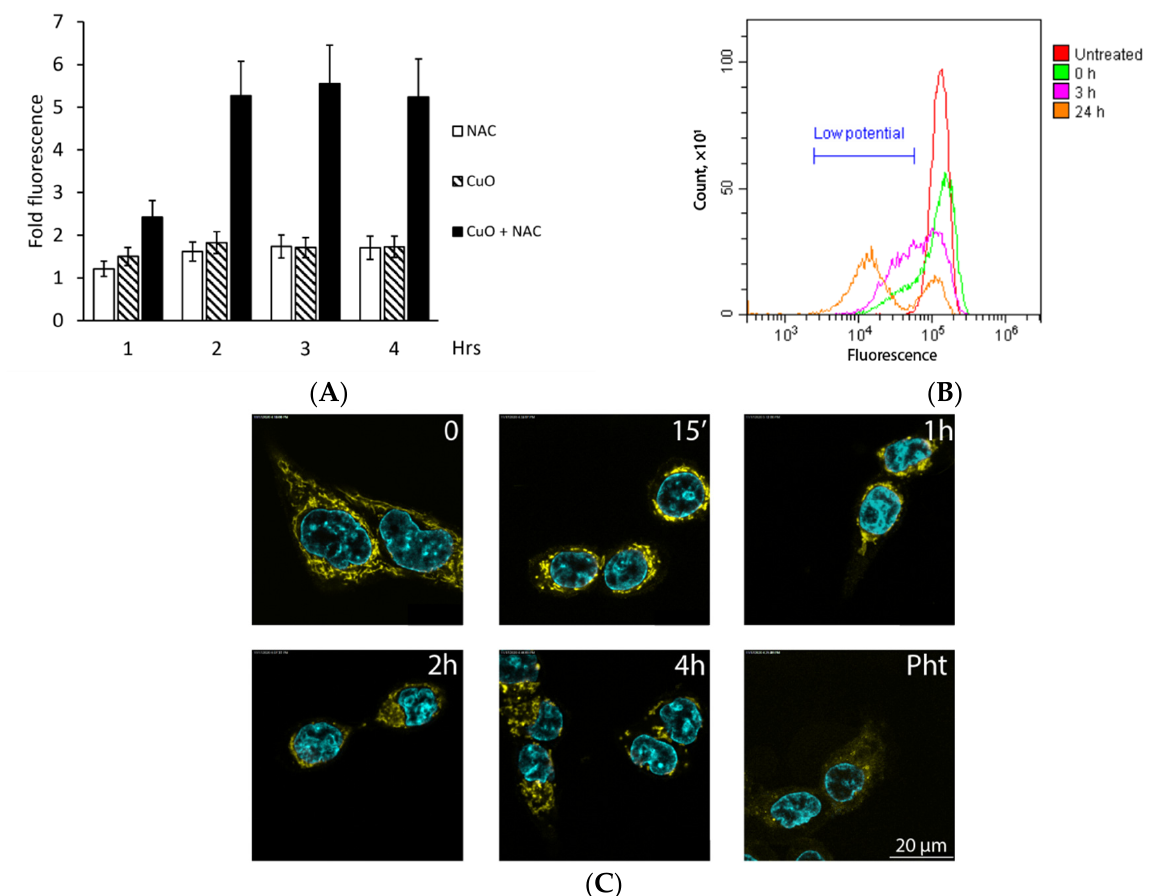
Figure 2. ROS burst and mitochondrial responses upon treatment with the combination of 1 µ g/mL CuO and 1 mM NAC. ( A , B ): K562 cells; C : HCT116 cells. ( A ) Carboxy-H 2 DCFDA (5 µ M) was added 30 min before the addition of the combination. Cell-associated fluorescence was measured in the FITC channel. Mean fluorescence intensity in untreated (no combination, carboxy-H 2 DCFDA only) cells was taken as 1. Data are mean+SD of three experiments. ( B ) Time-dependent decrease in mitochondrial electric potential (shown with the low potential marker). ( C ) Cells were labeled with the ROS indicator DHR 123 (yellow) and the nuclear stain Hoechst 33258 (blue) and analyzed by laser confocal microscopy. Pht,